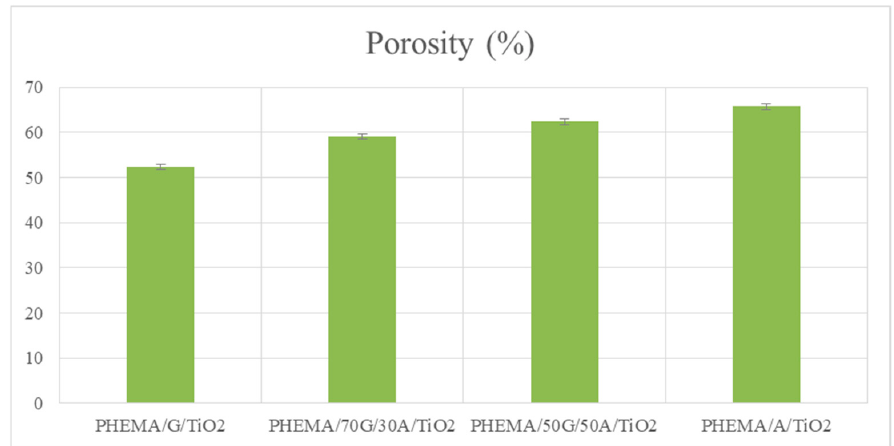
Figure 3. Porosity values for PHEMA/G/A/TiO 2 hybrid scaffolds.